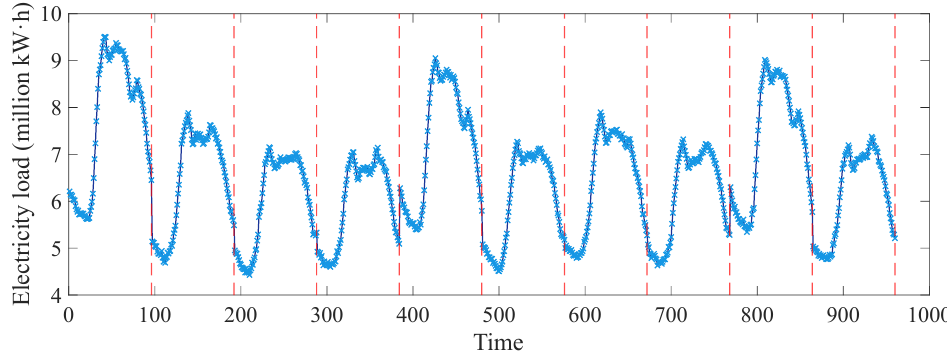
Figure 1. An illustration of multi-scale time